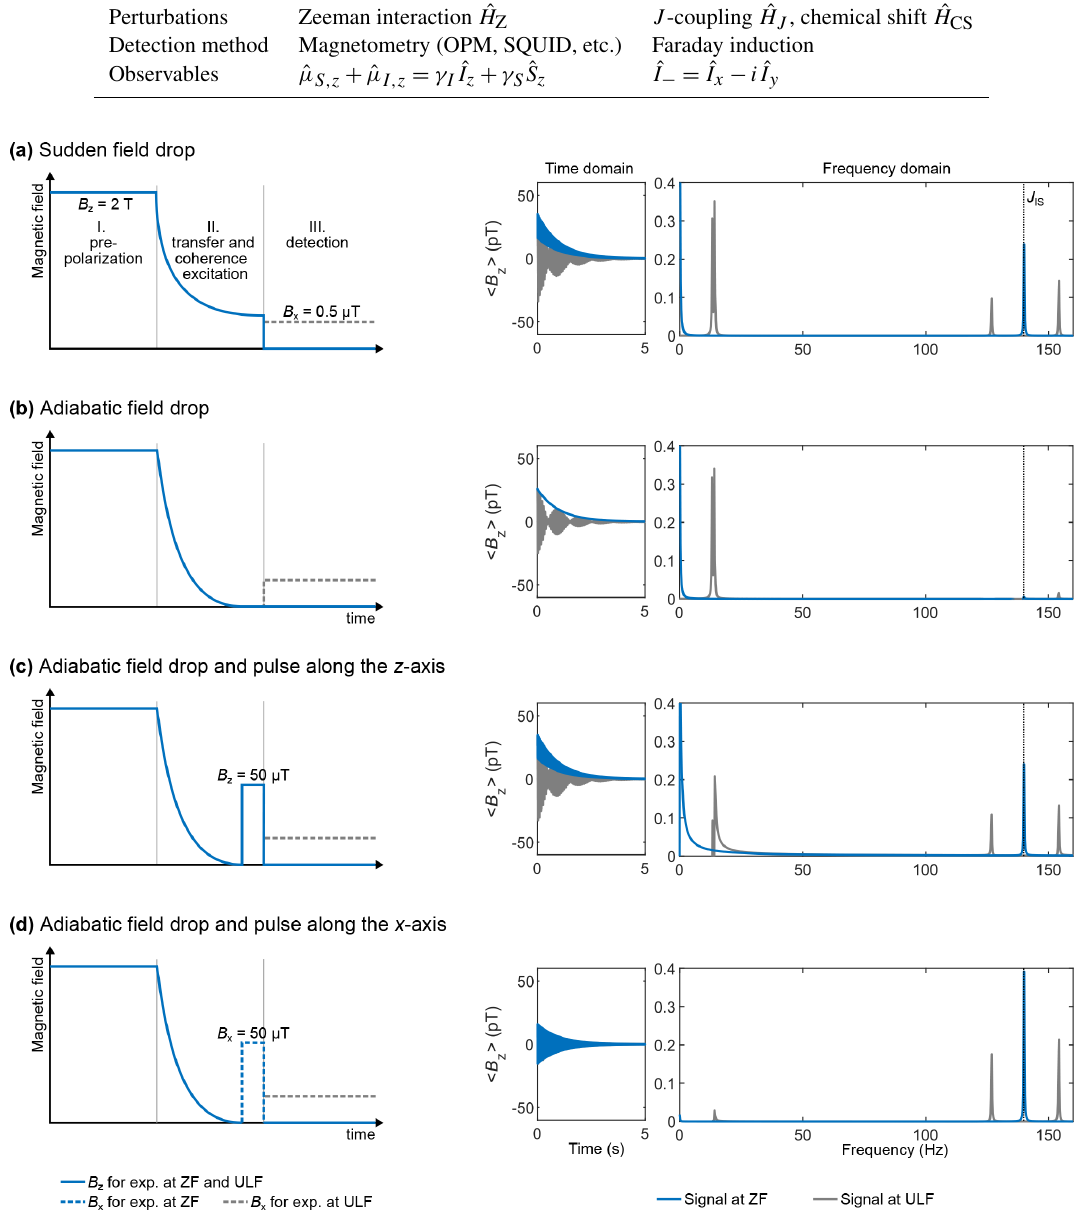
Figure 4. Excitation schemes for an XA spin system corresponding to 13 C and 1 H spins with a J coupling of 140Hz and corresponding simulated time domain signals and spectra. The vertical dashed line indicates the J coupling. The time domain signal was computed by propagating the density matrix under the effect of the Hamiltonian for a total time of 5s (parameter t aq ), discretized into 4096 points (parameter K ), and corresponding to time intervals d t of 1.2207ms (parameter τ D ). A monoexponential apodization function was applied to the time domain signal, with a coherence time constant T 2 of 1s. The apodized time domain signal was Fourier transformed with zero-filling to 65536